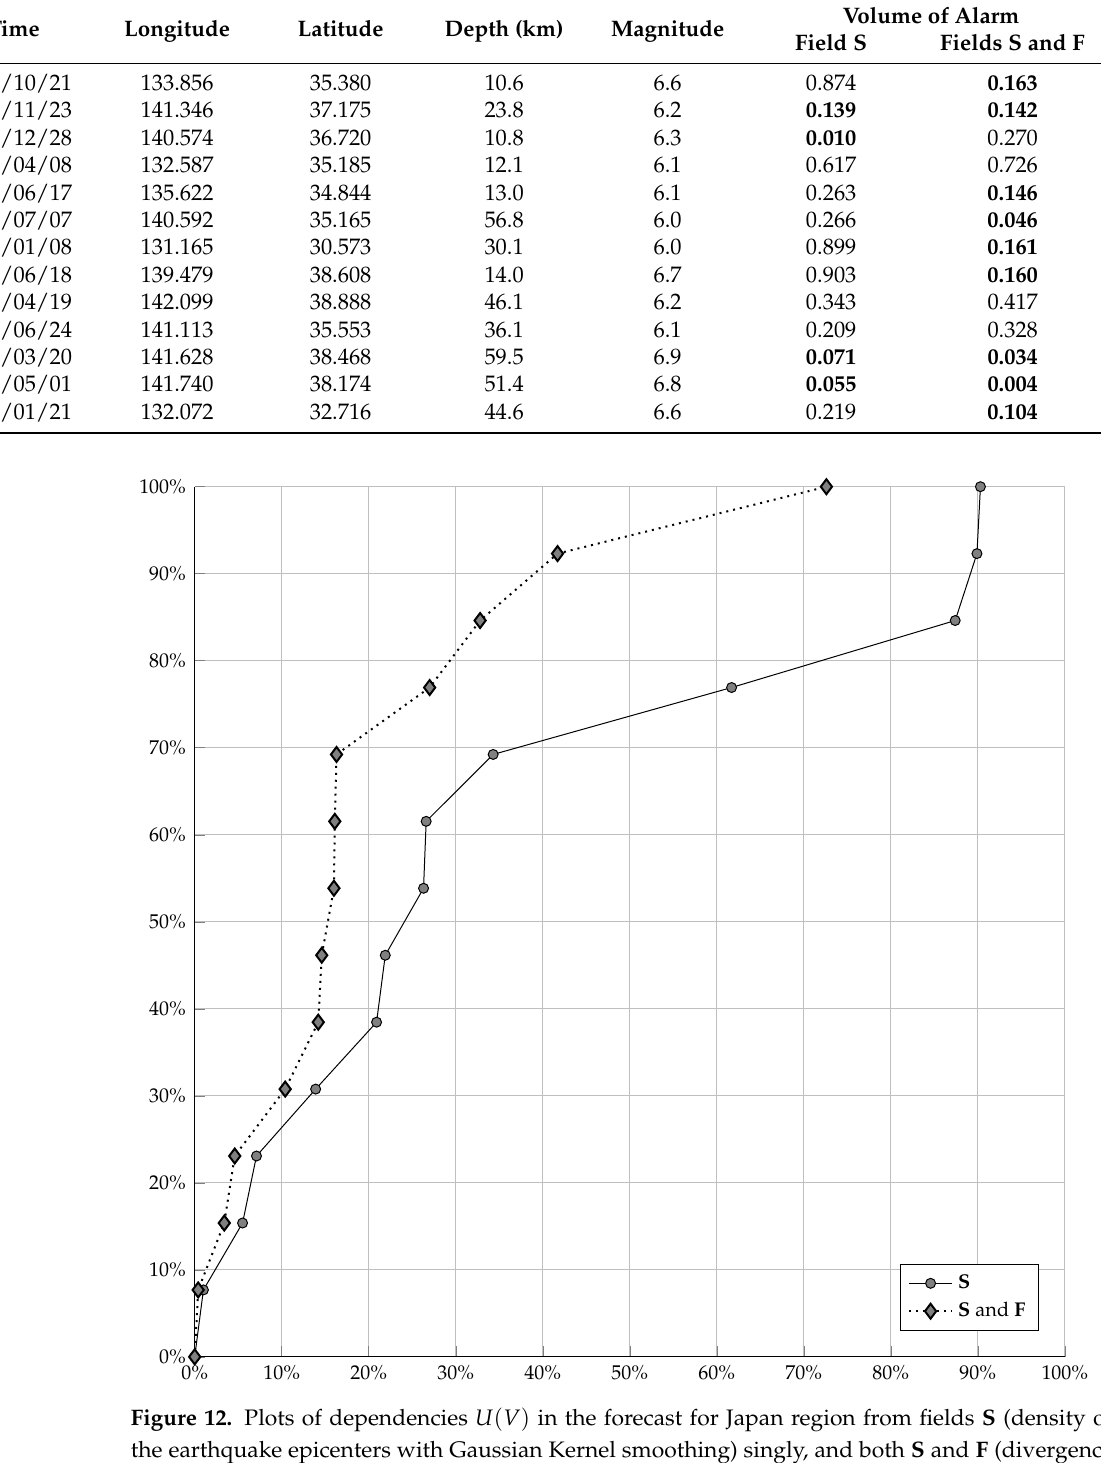
Table 4. Results of forecasting target earthquakes in Japan.